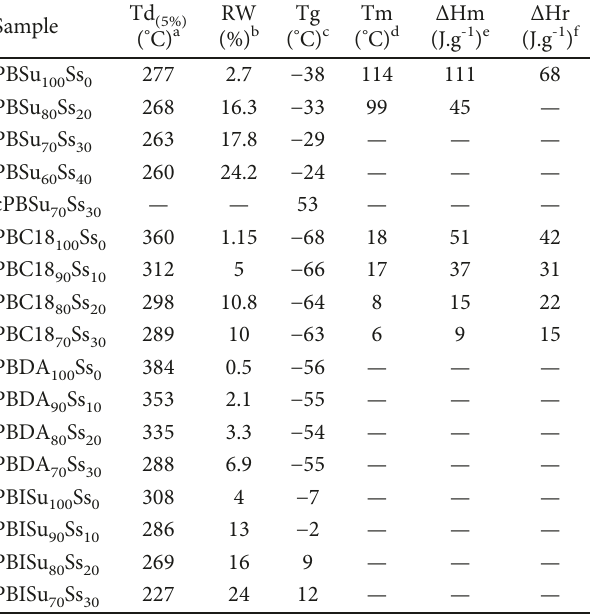
Table 3: Thermal properties of biobased oligoesters.